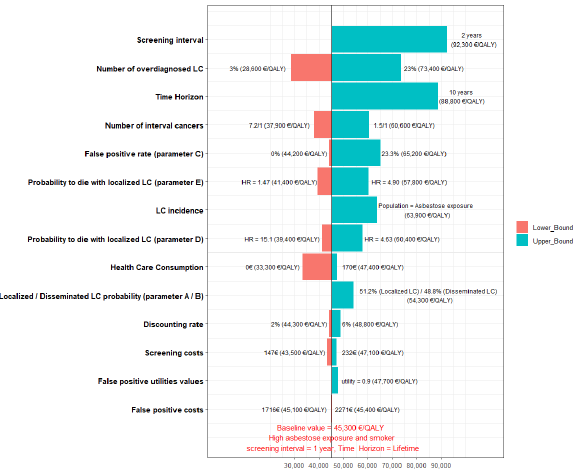
Figure 2. Tornado diagram of the sensitivity analysis representing the variability of ICER according to each parameter uncertainty, with baseline value corresponding to the strategy “scan every 2 years from 55 years of age for smokers with high exposure to asbestos, lifetime horizon”. LC, lung cancer; ICER, incremental cost-effectiveness ratio; QALYs, quality-adjusted life years.